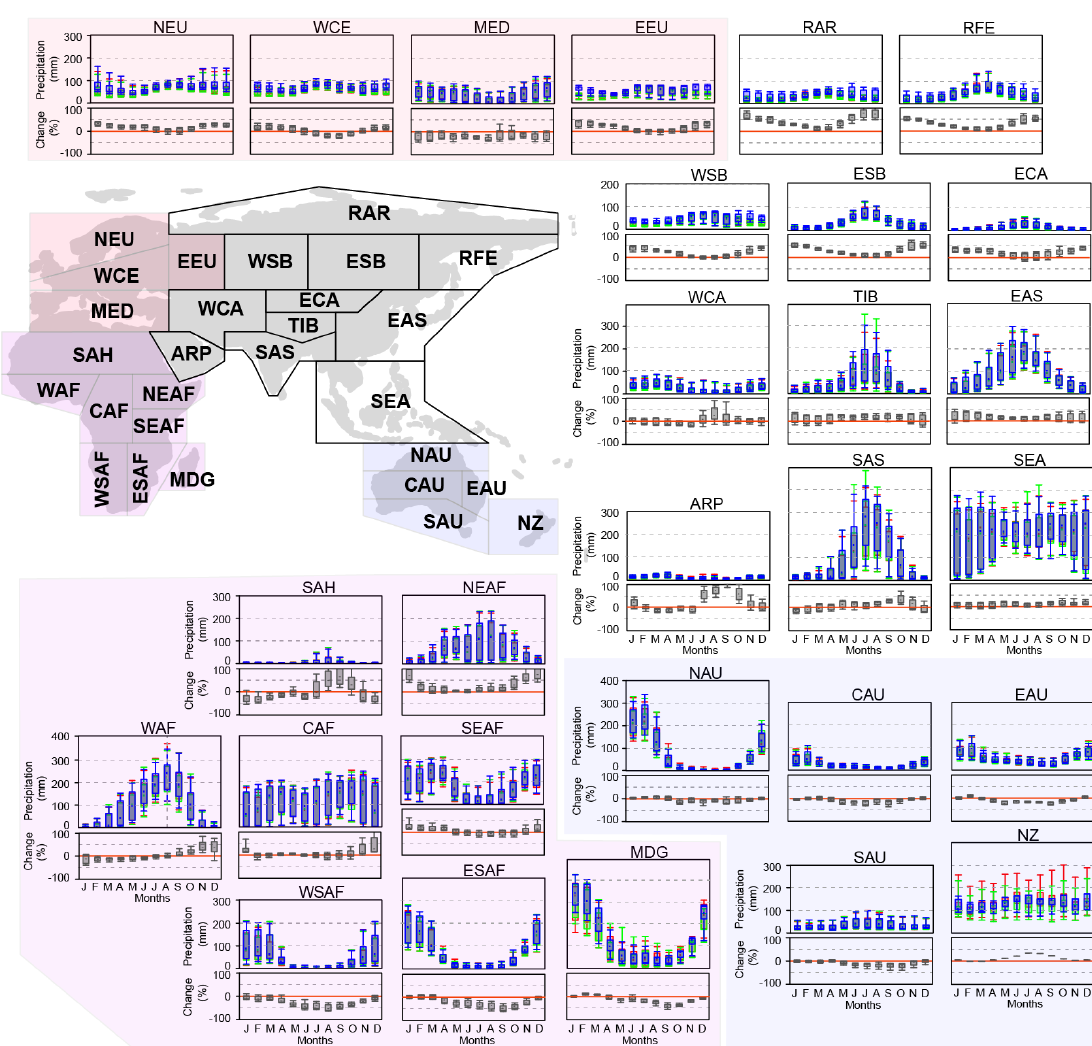
Figure 4. As in Fig. 3 but for Europe, Asia and Australasia.